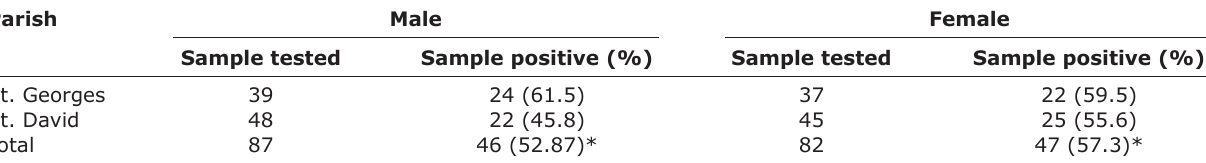
Table-2: Prevalence of Giardia antibody (anti-GD) in serum of brown rats from Grenada according to gender. Parish